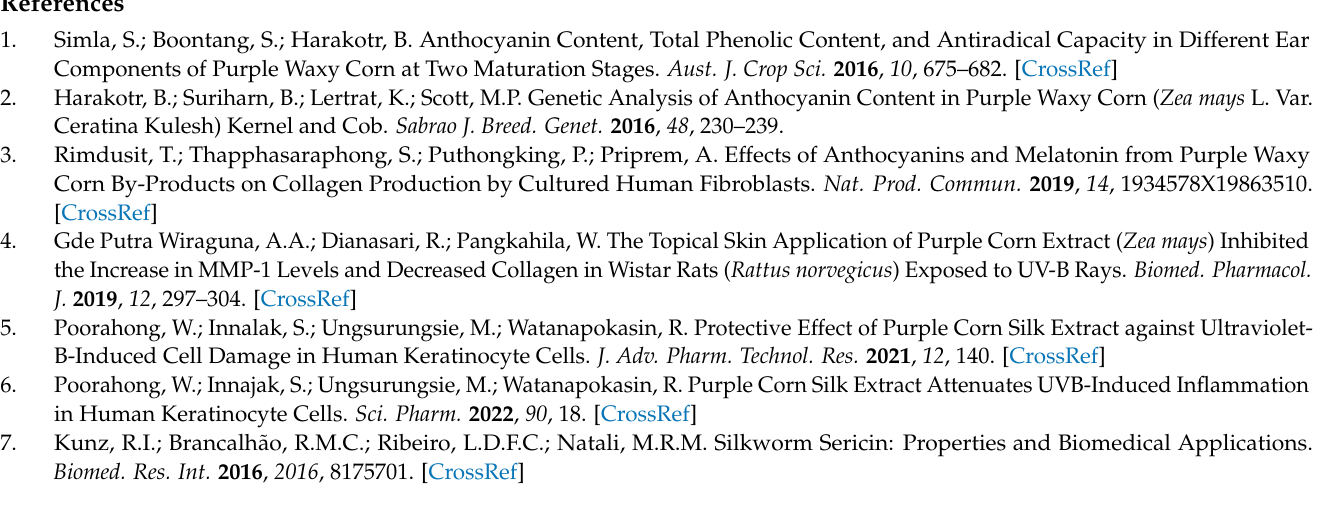
PVA and alginate on cell viability of B16F10 cells after treatment for 24, 48 h.; Figure S3: Effects of sericin, PWCCS, PVA and alginate compared with ascorbic acid C 25 µ g/mL (Vit C) for cell viability on HaCaT cells after treatment for 2, 6 and 24 h. Data represent the mean ± SEM of three replicates.; Figure S4: Effects of UV-irradiation for various time of formulation pretreatment of 2% sericin (Ser2), 0.15% PWCCS (PWCCS0.15), formulations (S2 and S4) and ascorbic acid 25 µ g/mL (Vit C) on HaCaT cells (A) 2 h pretreatment formulations (B) 6 h pretreatment formulations and (C) 24 h pretreatment formulations. Data represents the mean ± SEM of three replicates.; Figure S5: Morphology of UVB irradiation on HaCaT cells: (A) Untreated cells, (B) Cells irradiated with UVB 30 mJ/cm 2 , (C) Cells irradiated with UVB 60 mJ/cm 2 , (D) Cells irradiated with UVB 120 mJ/cm 2 .; Figure S6: Effects of sericin, PWCCS, Alginate, and PVA on cell viability of NHDF cells after 12, 24, and 48 h.; Figure S7: Viability of NHDF cells exposed to 2% sericin (Ser2), 0.15% PWCCS (PWCCS0.15), 0.2% alginate (Ag0.2), 25 µ g/mL ascorbic acid (Vit C), formulations S1–S6 for 12, 24 and 48 h. Data represent the mean ± SEM of three replicates.; Table S1: Structure of anthocyanin derivatives and calculated molecular ion and fragment ion for MS